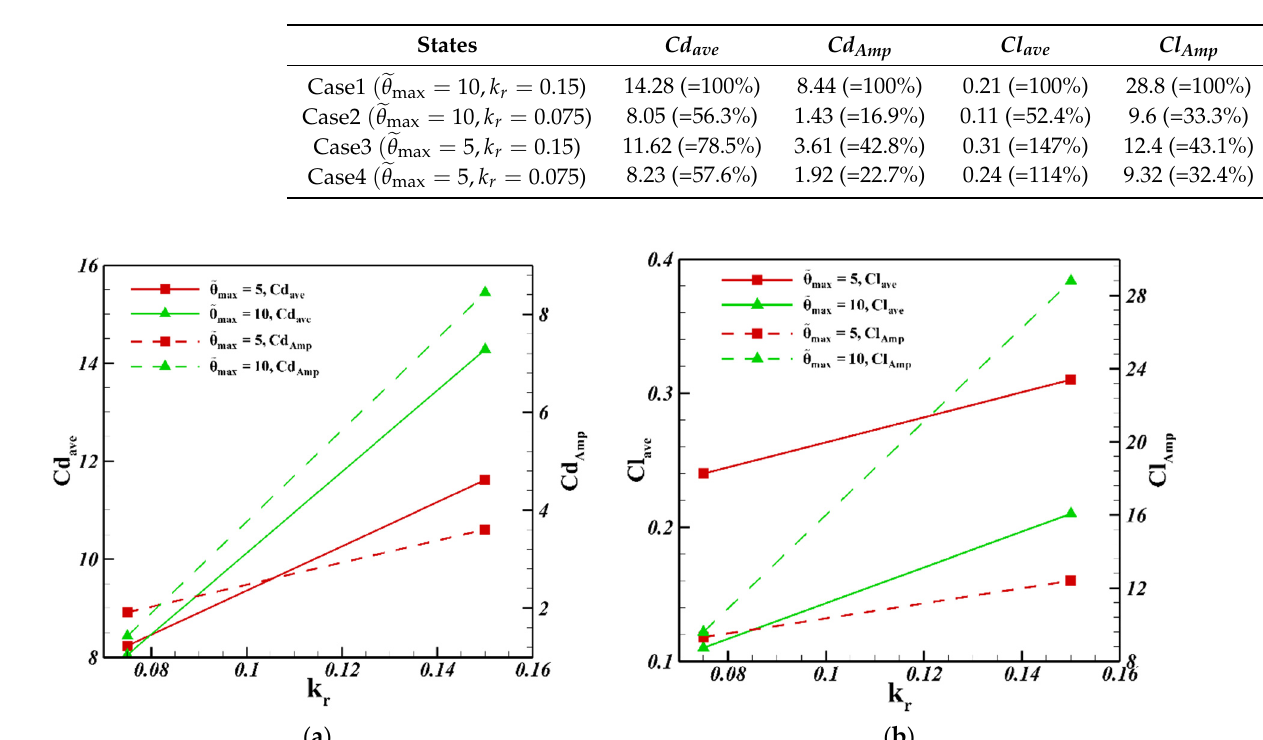
Table 3. The specific value of the change in the lift-drag coefficient of the oscillating cylinder under each motion state.